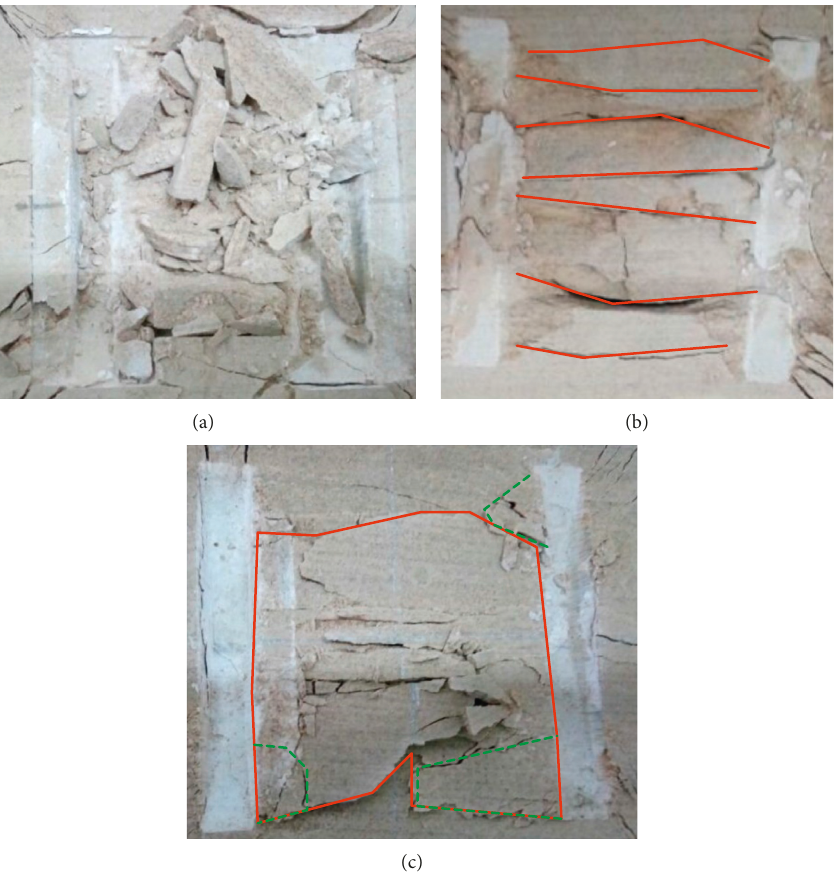
Figure 4: Rock breakages for the indentation depth of 7.7 mm when the spacings were (a) 60mm, (b) 70 mm, and (c) 80mm.